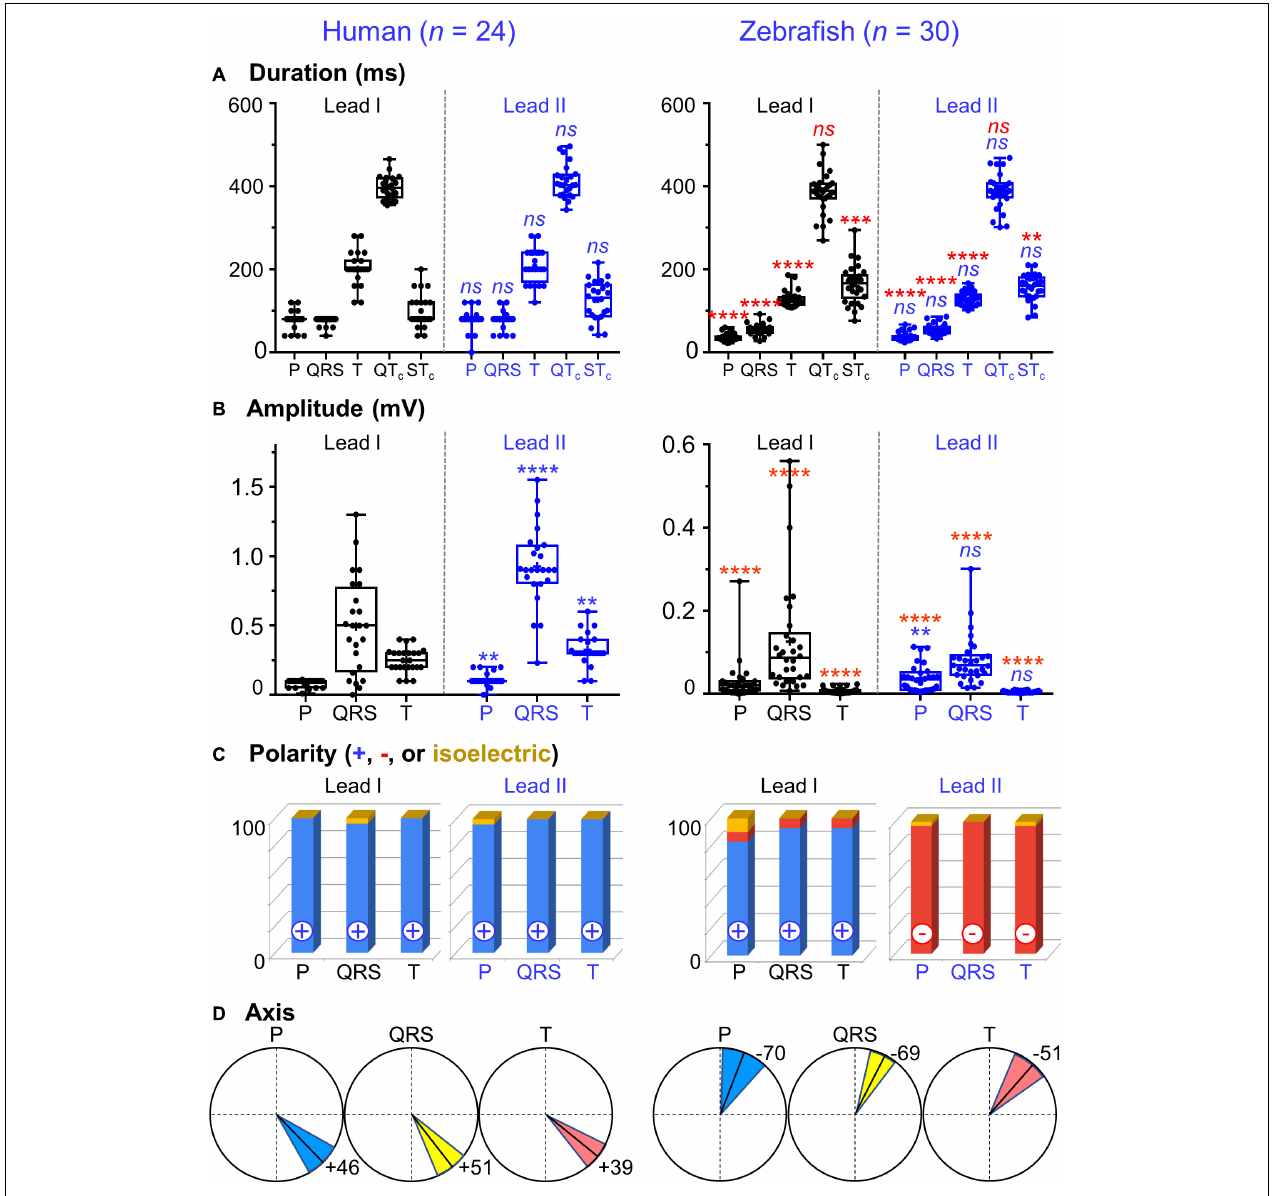
FIGURE 3 | Lead- and species-comparison. (A) No lead differences existed in the durations of any waveforms for either species. However, for both leads, corrected QT (QTc) interval was the only waveform of similar duration in both species and corrected ST (STc) segment was the only waveform longer in zebrafish than in humans. (B) Lead II consistently registered larger amplitudes than lead I for all three human ECG waveforms, but only for the zebrafish P-wave. Not surprisingly, all ECG voltages were smaller in zebrafish than in humans. (C) The P, QRS, and T polarities were predominantly positive in both human leads I-II and zebrafish lead I, but negative in zebrafish lead II. Consequently, T-wave concordance was positive in human leads I-II and zebrafish lead I, but negative in zebrafish lead II. (D) The human and zebrafish cardiac electrical axes in the frontal plane are reflections across 0 ◦ in the Cabrera system, in Quadrants I and IV, respectively. In both species, the dominant QRS axis defined the main heart axis. Symbols: (A,B) Sample sizes: Human ( n = 24), zebrafish ( n = 30). Box-plot bar, mean; whiskers, SD; circles, subjects. P -values in blue for lead comparison of the same subject (Wilcoxon paired signed rank test), in red for species comparison of the same